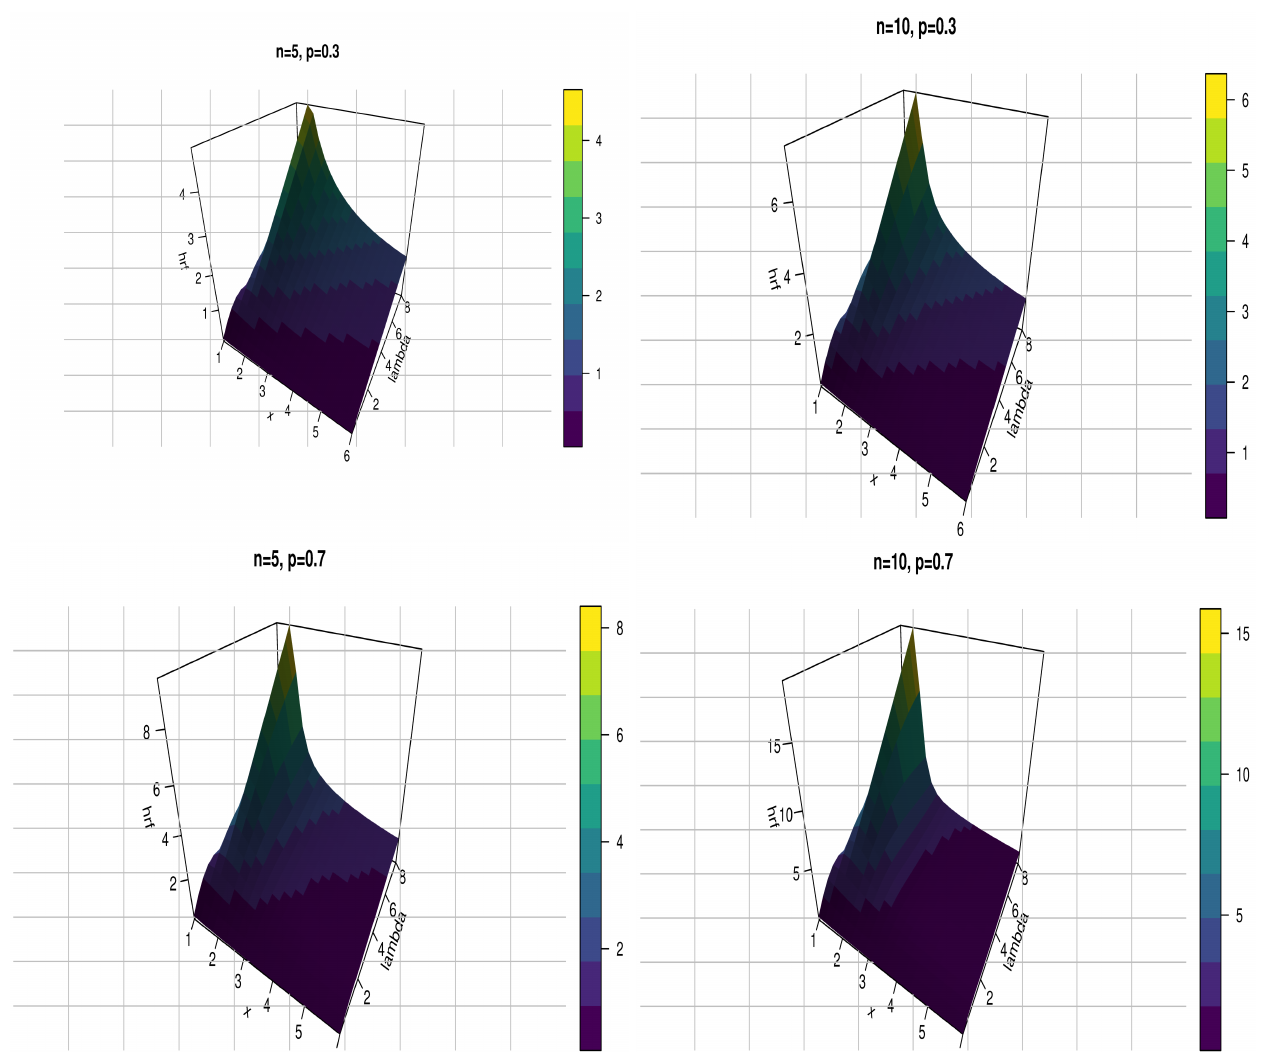
Figure 6. Three-dimensional different shapes of hrf for FB distribution at β =